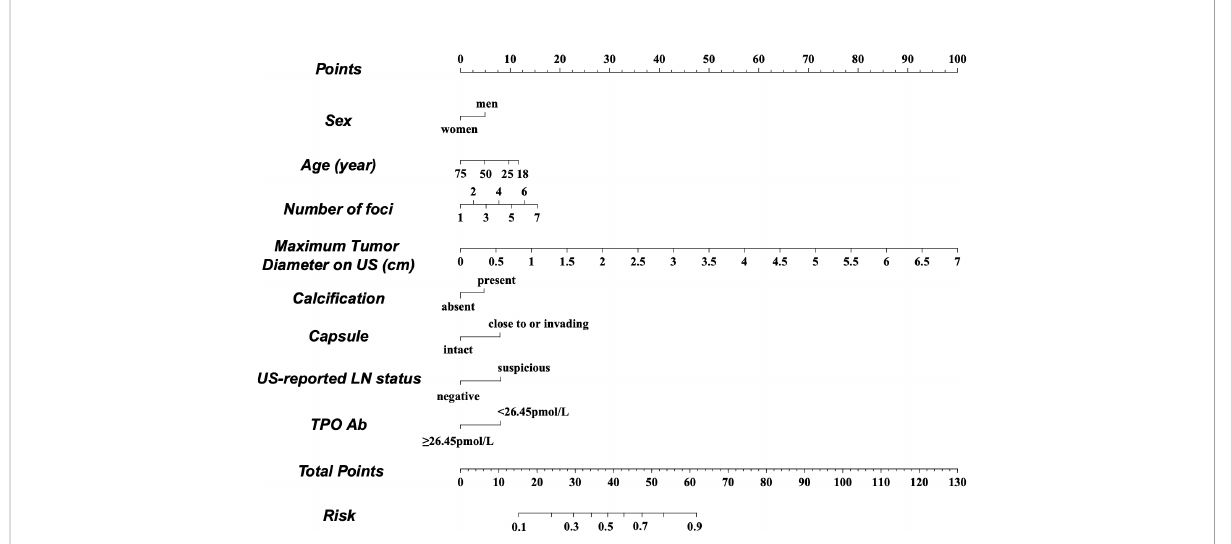
FIGURE 3 Preoperative factor-based nomogram used for predicting the prognostic risk in patients with PTC. US, ultrasound; LN, lymph node; TPO, thyroid